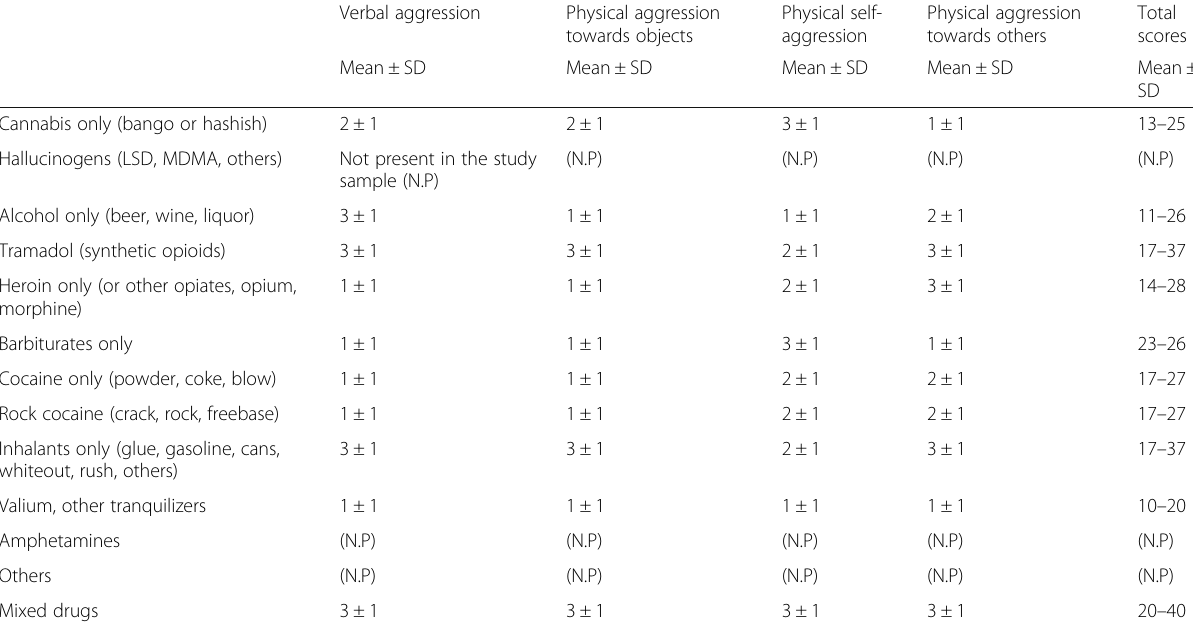
Table 5 Relation between type of drug of abuse and violence according to (MOAS) Verbal aggression Physical aggression towards